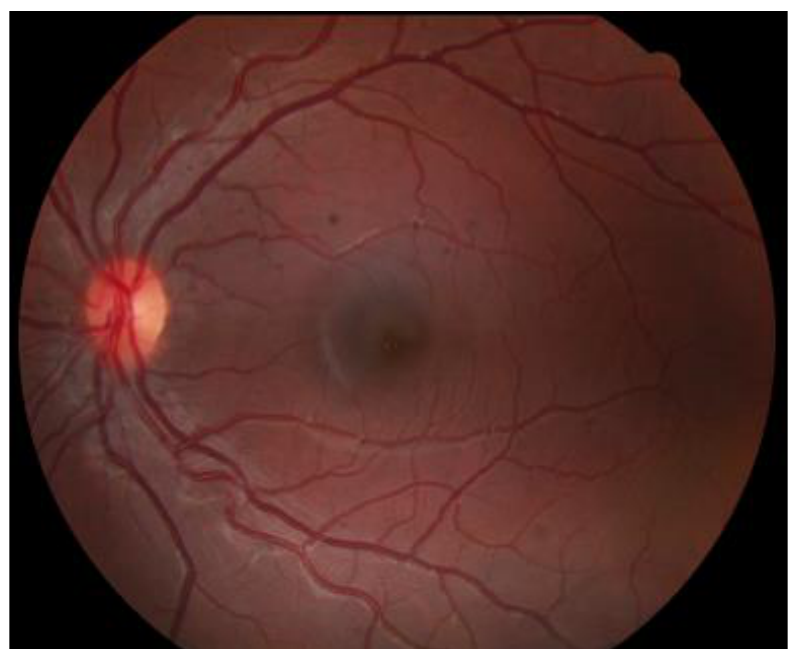
Figure 7. Retinal pigment epithelium hypertrophy.